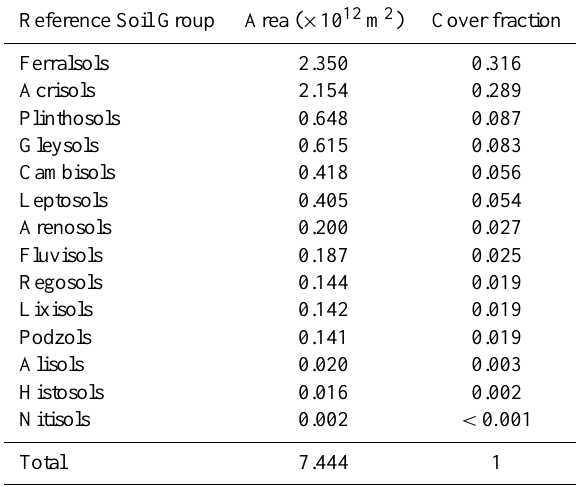
Table 1. Soil area beneath forest vegetation in